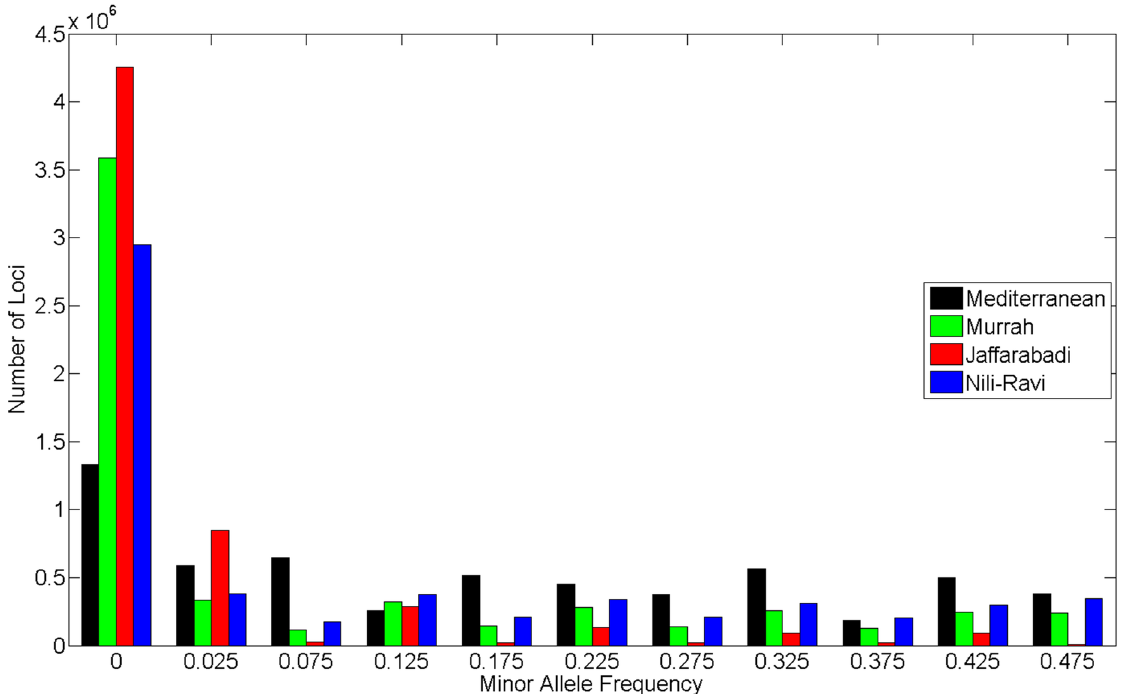
Fig 1. SNP MAF. Distributionof SNP Minor Allele Frequency (MAF) for Mediterranean, Murrah, Jaffarabadi and Nili-Ravibreeds used in the designof the SNP panel.